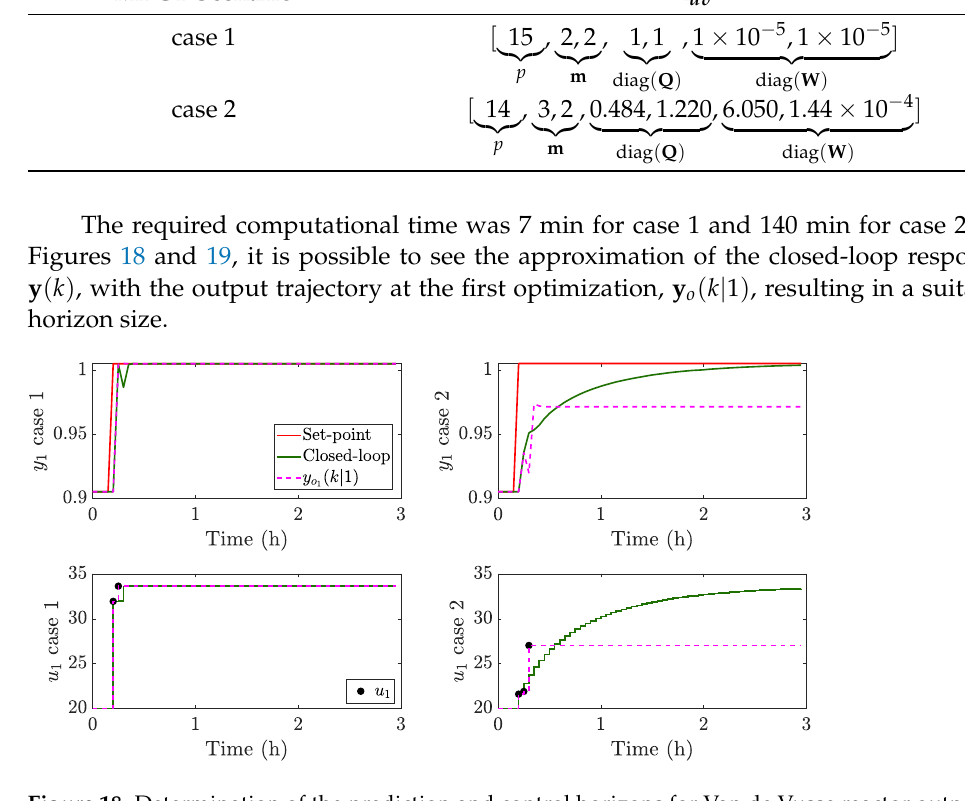
Figure 18. Determination of the prediction and control horizons for Van de Vusse reactor output y 1 and input u 1 .